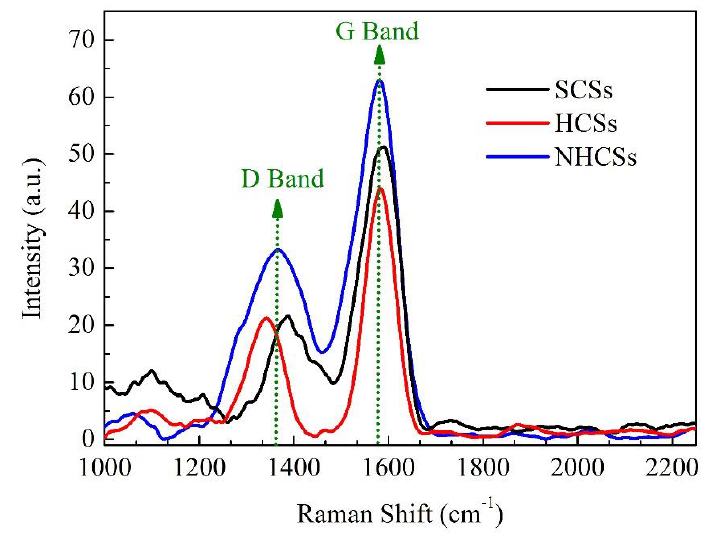
Figure 6. Raman spectra for the SCSs, HCSs and NHCSs.